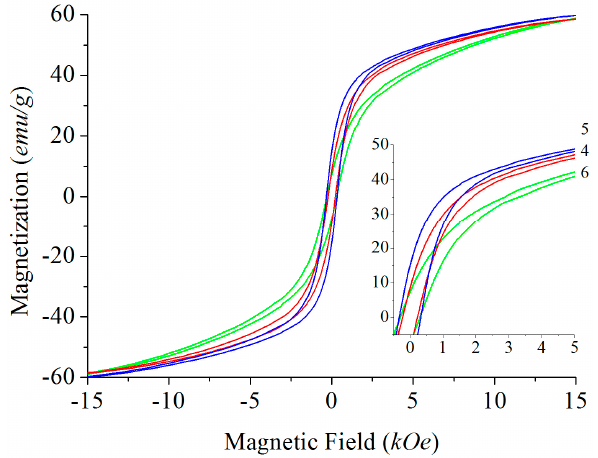
Figure 7. Hysteresis loops of Pb-substituted barium hexaferrite samples Ba 1– x Pb x Fe 12 O 19 with x = 0.23(2), 0.44(2), and 0.80(2) for 4 (red), 5 (blue), and 6 (green), respectively (compare with Table 2). Insert figure: Detailed view of the section between 0 and 5 kOe.